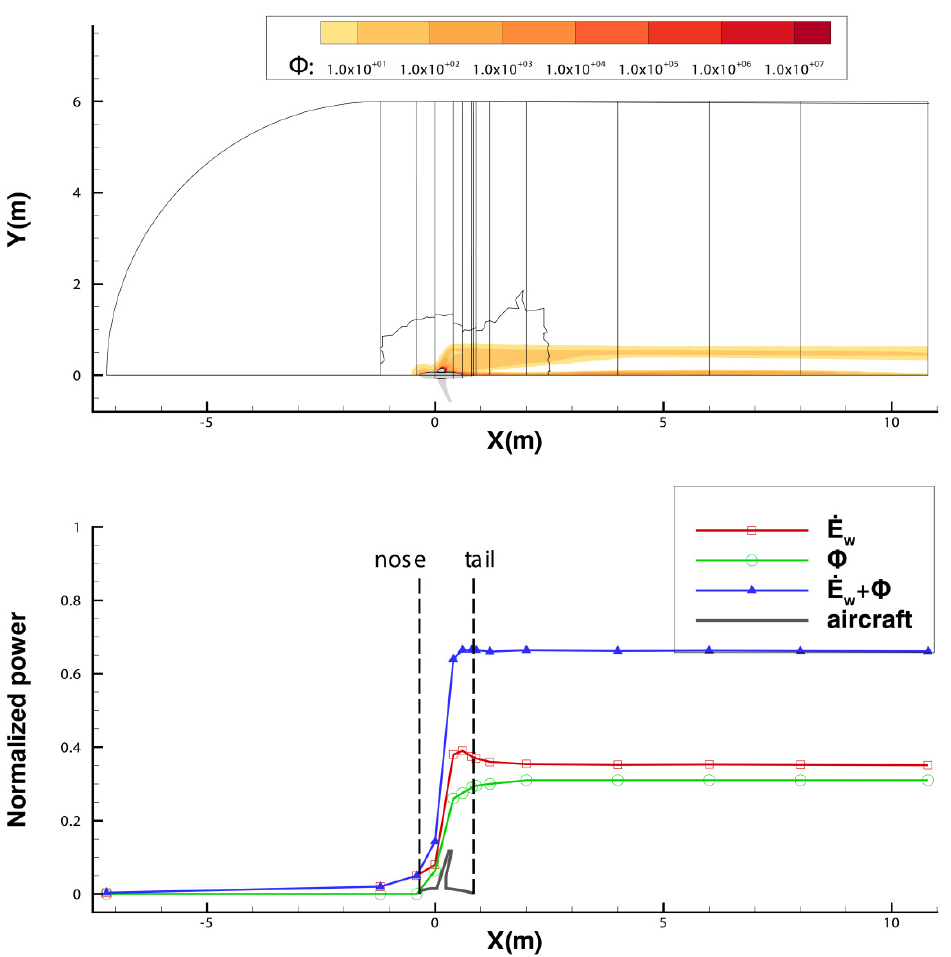
Figure 13. The intensity of viscous dissipation and the power conversion process of the wing body configuration.